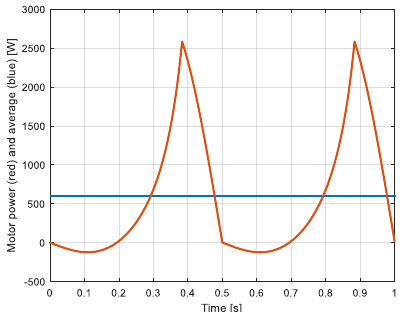
Figure 10. Total force (horizontal) (N).